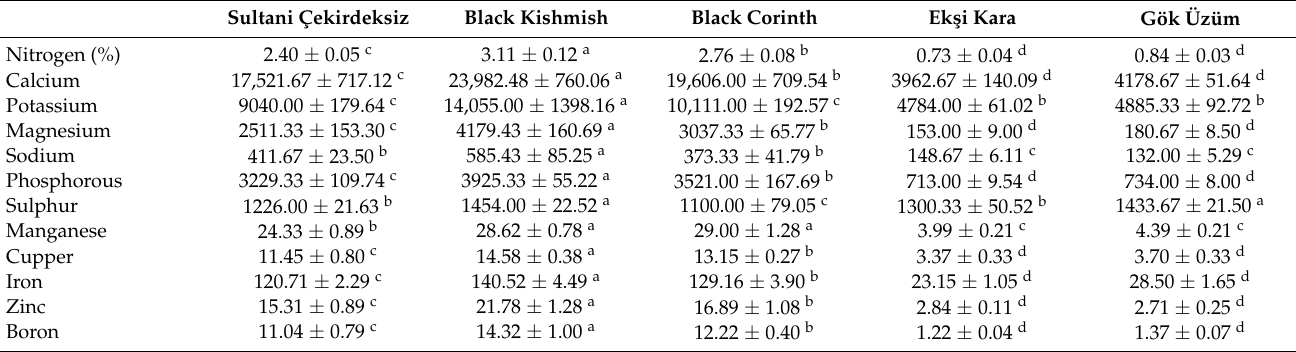
Table 6. Mineral contents (ppm) of two stenospermocarpy varieties (Sultani Çekirdeksiz and Black Kishmish); one parthenocarpic variety (Black Corinth), and two seeded varieties (Ek¸si Kara and Gök Üzüm) in 2020